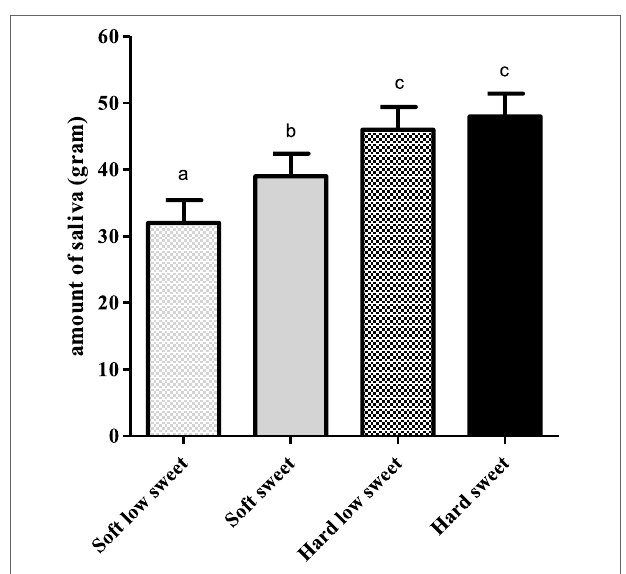
FigUre 8 | Estimated mean ± SEM saliva content (in grams) of expectorated boli per model food type. Bars with different letters are significantly